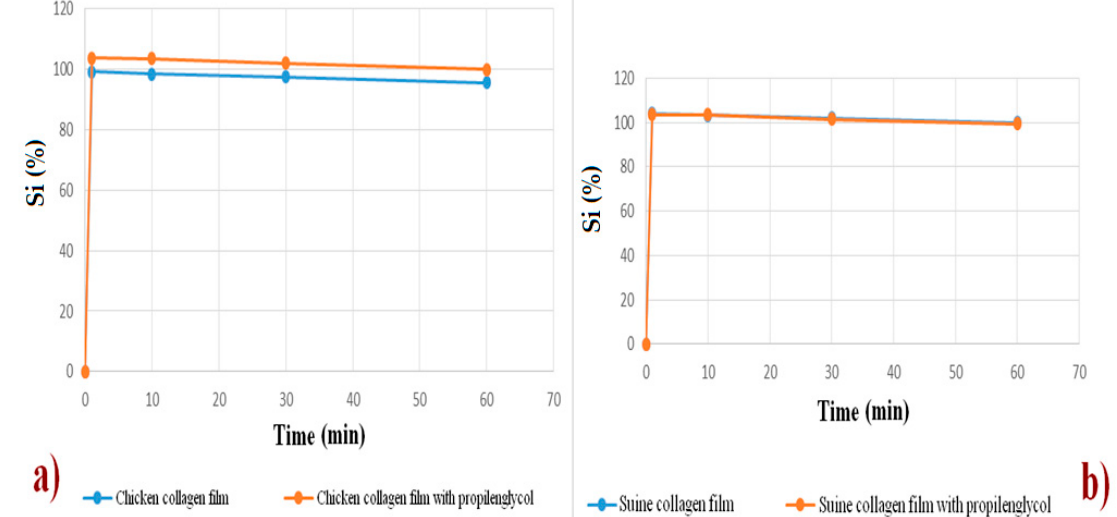
Figure 9. Polymer degradation process, based in swelling index curves . ( a ) chicken collagen samples and ( b ) swine collagen samples.